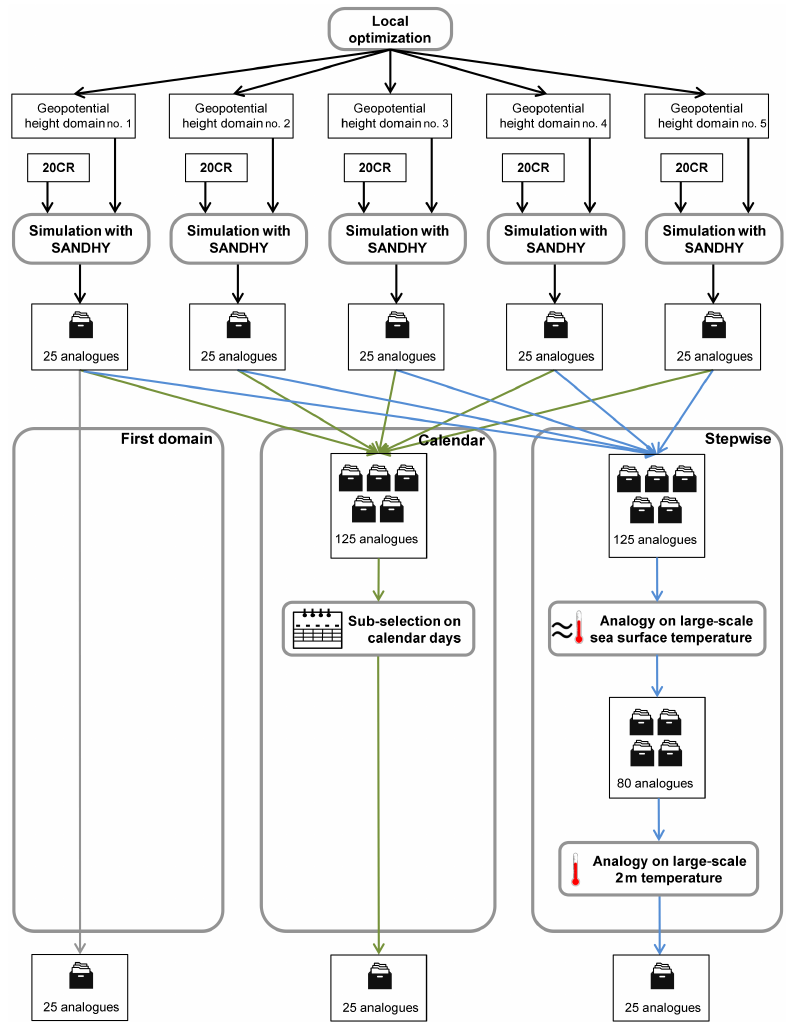
Figure A2. Synthetic diagram showing the sequence of steps for reconstructing precipitation and temperature over a climatically homoge- neous zone for a specific target date using the three subselection methods described in the main